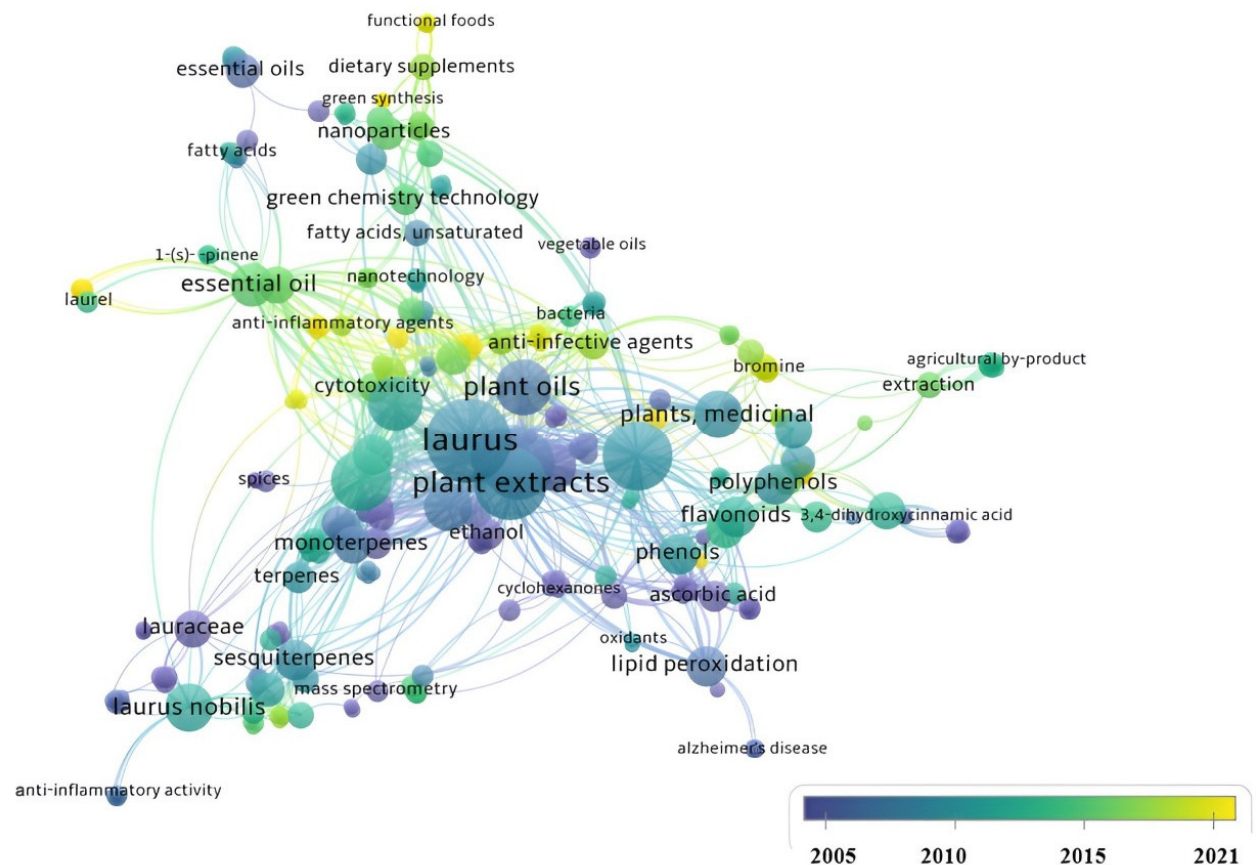
Figure 2. Keyword density visualization map of L. nobilis publications.